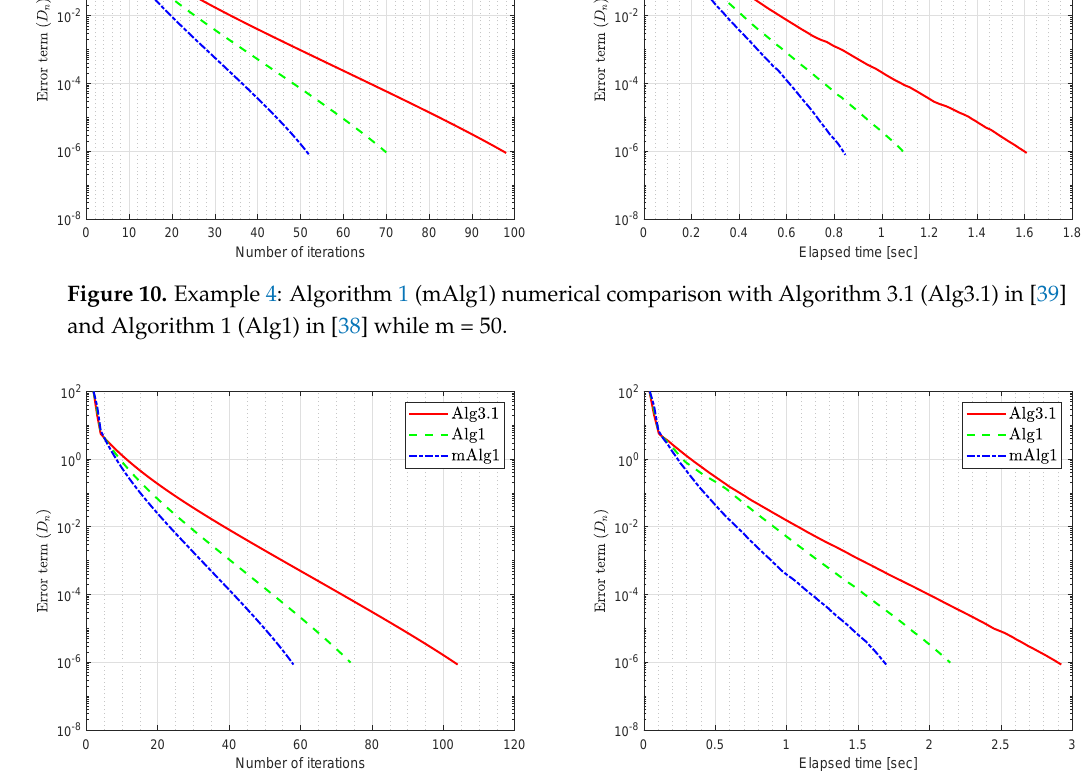
Figure 11. Example 4: Algorithm 1 (mAlg1) numerical comparison with Algorithm 3.1 (Alg3.1) in [39] and Algorithm 1 (Alg1) in [38] while m =